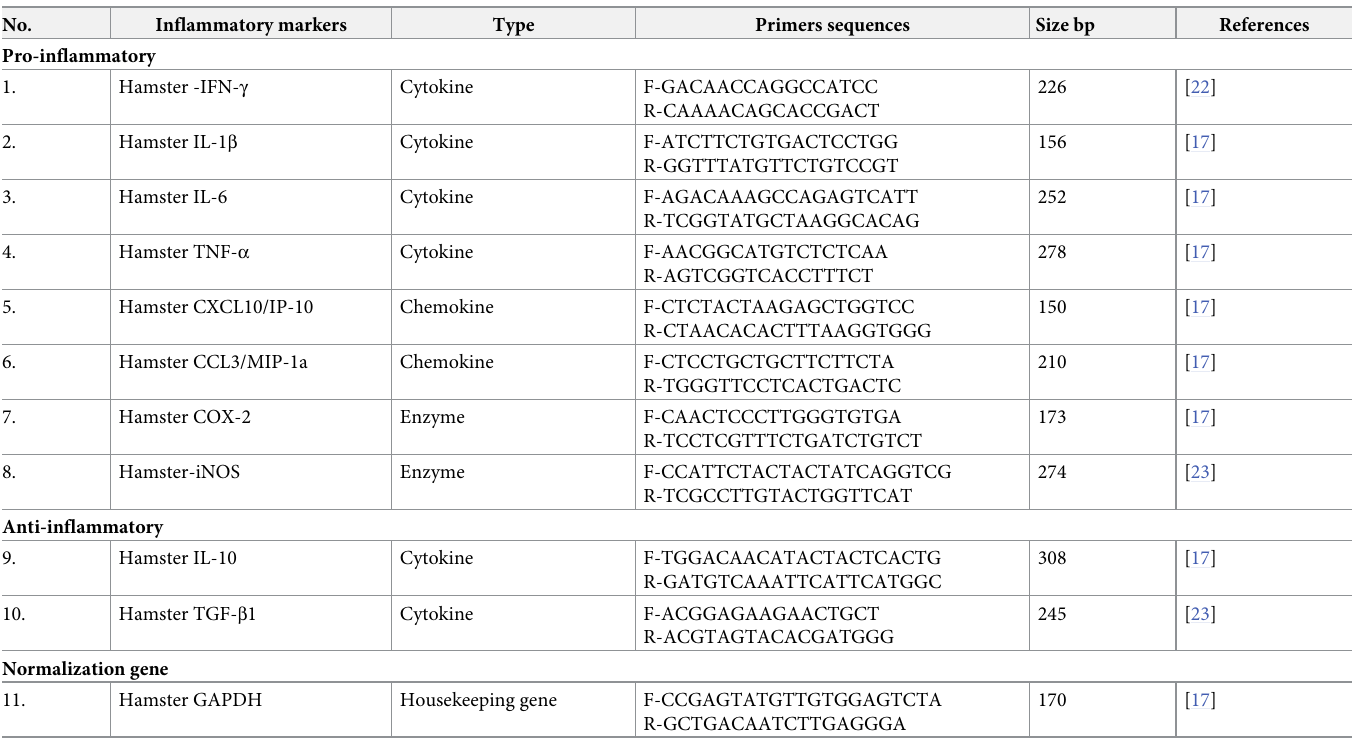
Table 1. List of inflammatory markers and primers used in this study.